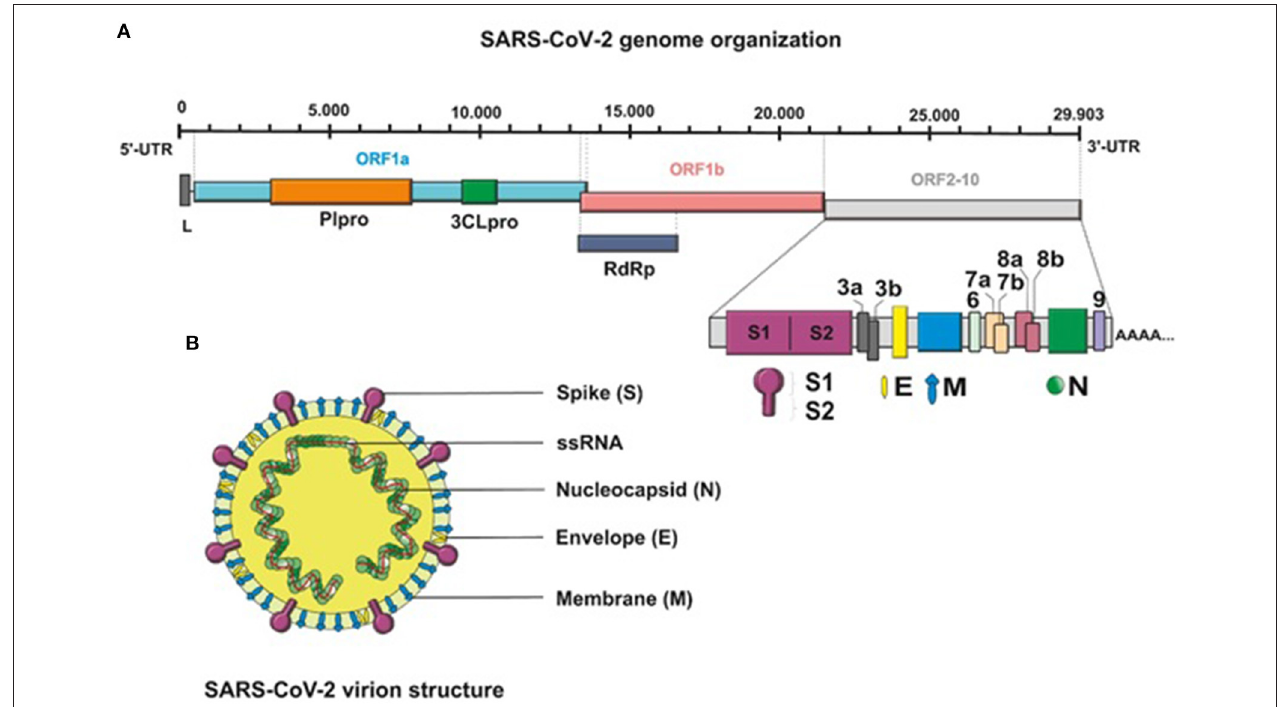
FIGURE 1 | (A) Schematic presentation of the full-length genomic RNA (29,903 nt), and transcribed canonical subgenomic RNAs (sgRNA) of SARS-CoV-2 virus. In addition to the genomic RNA that also serves as an mRNA encoding two overlapping ORFs, ORF1a and ORF1b, nine major subgenomic RNAs are produced. (B) Schematic structure of the SARS-CoV-2 virion and its major structural